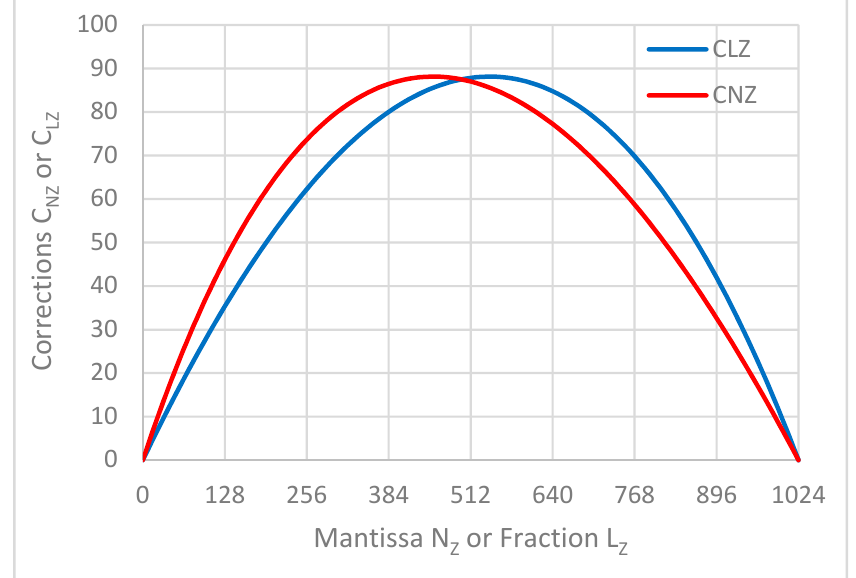
Figure 1. Diagram of correction functions from N Z to L Z (red plot) and from L Z to N Z (blue plot) for M = 1024 .